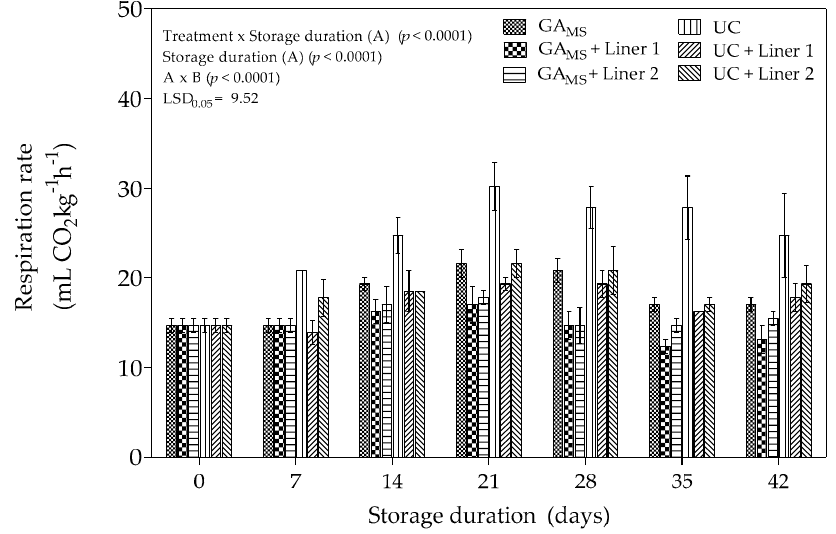
Figure 3. Respiration rate (mLCO 2 kg − 1 h − 1 ) of ‘Wonderful’ pomegranate coated and packaged in different polyliners and stored (5 ± 1 °C, 95 ± 2% RH) for 42 d. GA MS —gum Arabic (0.5% w / v ) and maize starch (0.5% w / v ); Liner 1—Xtend ® liner (20 µ mm perforations); Liner 2—perforated liner (4 mm perforations); UC—uncoated fruit. LSD 0.05 represents least significant difference ( p < 0.05).